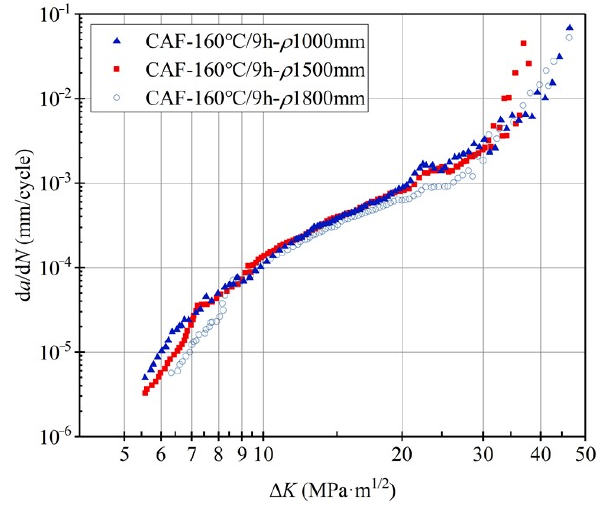
Figure 7. Fatigue-crack propagation rate curves of 2524 aluminum alloy under different creep stresses.